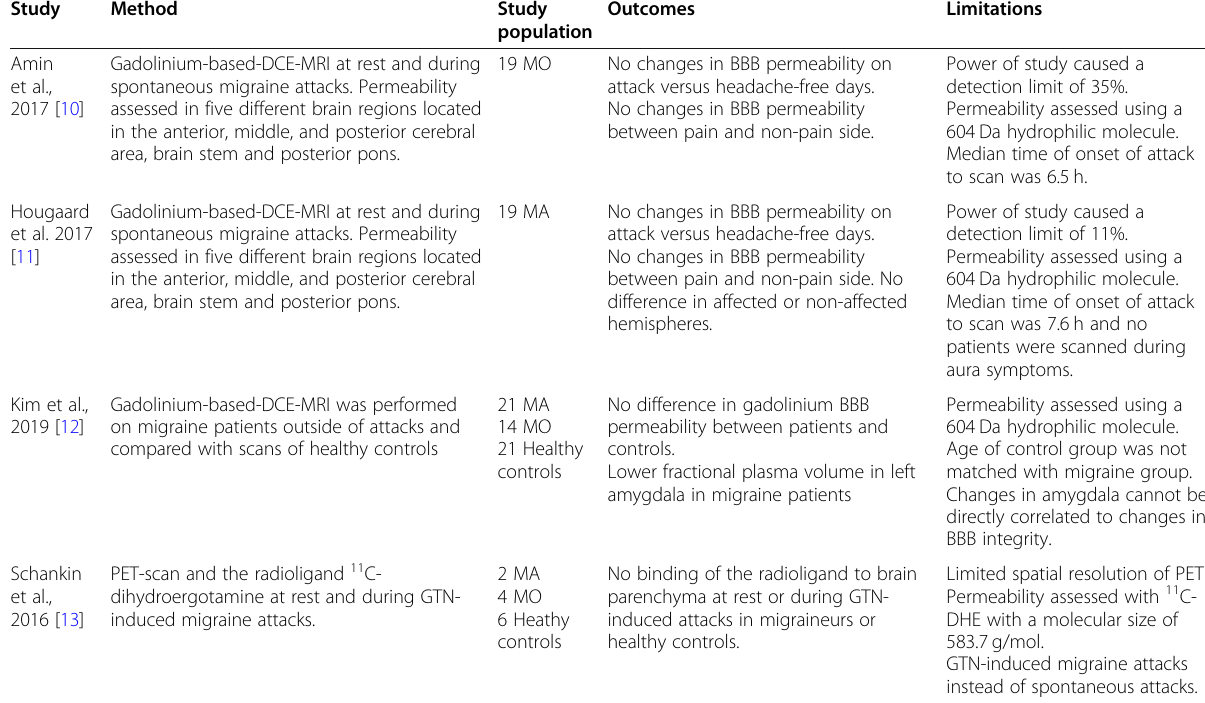
Table 1 Human experimental studies of BBB integrity in migraine Study Method Study